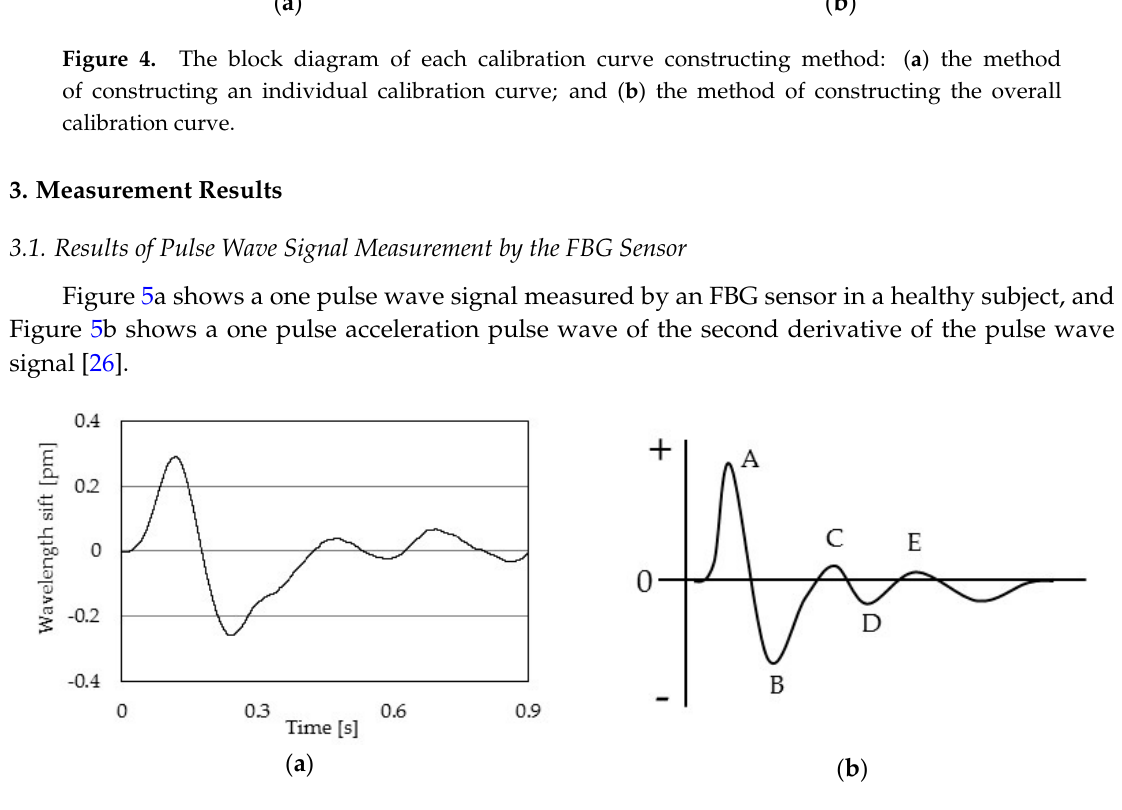
Figure 5. The pulse wave signals: ( a ) pulse wave signal measured by the FBG sensor; ( b ) pulse acceleration pulse wave of the second derivative of the pulse wave signal.